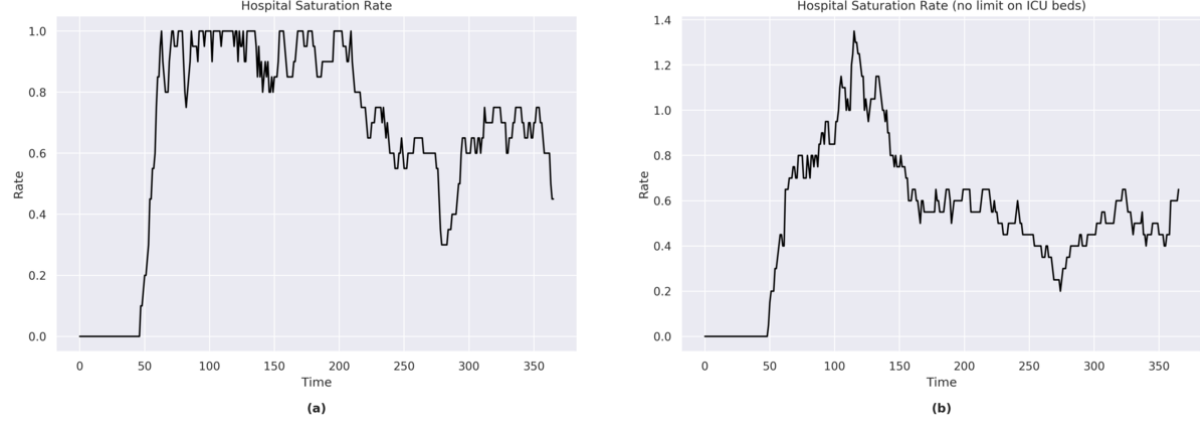
Figure 7. (a) Hospital saturation rate for Sweden. (b) Hospital saturation rate for Sweden (with no limit on the number of ICU beds). ICU: intensive care